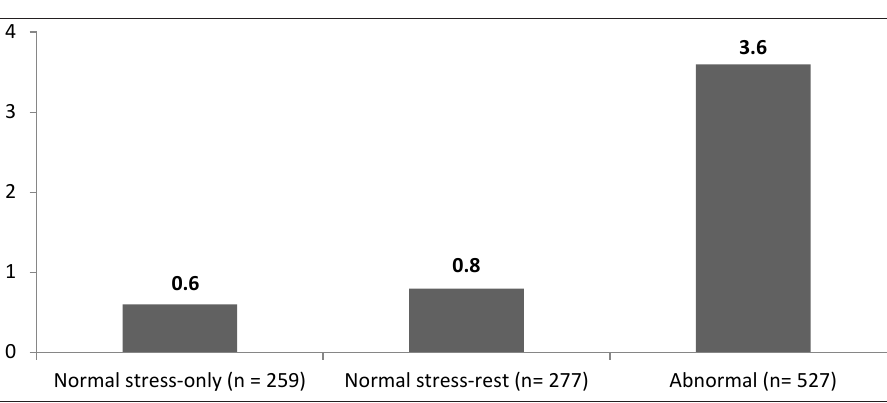
Normal stress-only (n = 259) Fig. 1. Frequency of hard events per year (%) as a function of stress SPECT result. Significant differences ( P < 0.001) are present between patients with normal and abnormal study. Patients with normal study are at low risk of cardiac death or nonfatal MI. Not significantly lower incidence of hard events was observed in the subgroup of patients with stress-only imaging ( P = 0.641).